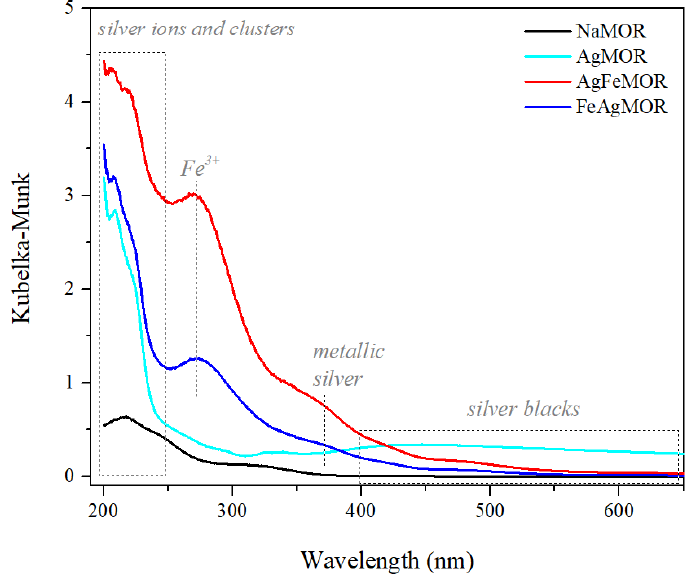
Figure 3. Diffuse reflectance UV-Vis spectra of the support, monometallic and bimetallic